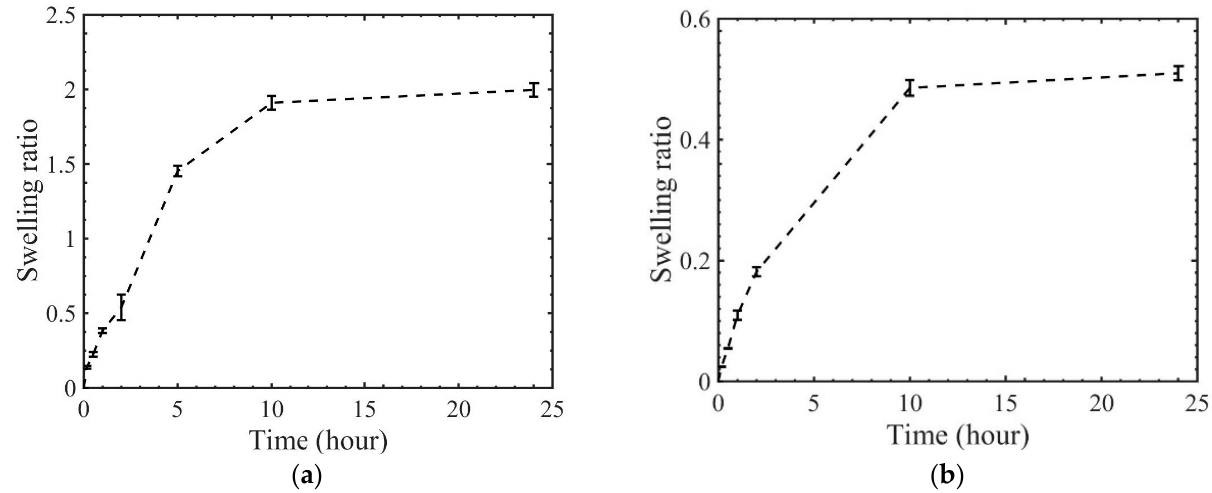
Figure 4. Swelling ratio of acrylate polymer with ( a ) 2 wt.% and ( b ) 20 wt.% crosslink density.